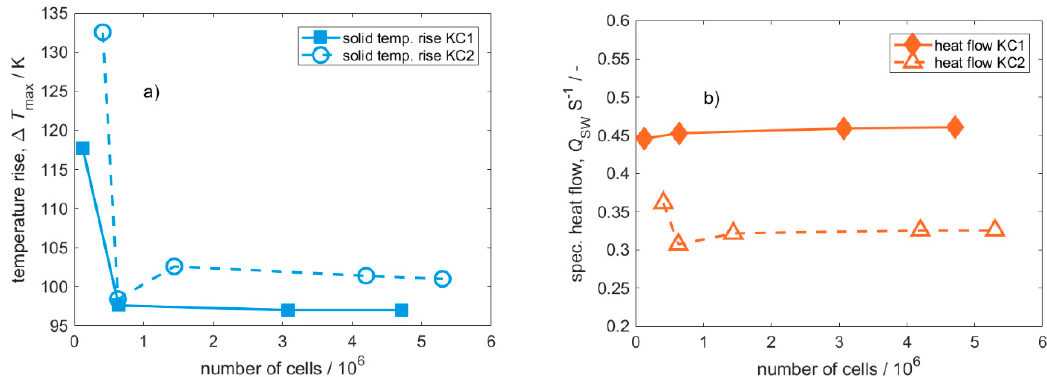
Figure A2. Grid independence study. ( a ) Solid temperature rise from initial 500 K plotted against number of cells; ( b ) specific heat flow from solid to wall plotted against number of cells. For both used geometries, the second-largest meshes (KC1: 3.1 mio. Cells; KC2 4.1 mio cells) were found to give reasonable results. Conditions: air; p = 1 bar, v = 4 m s − 1 .